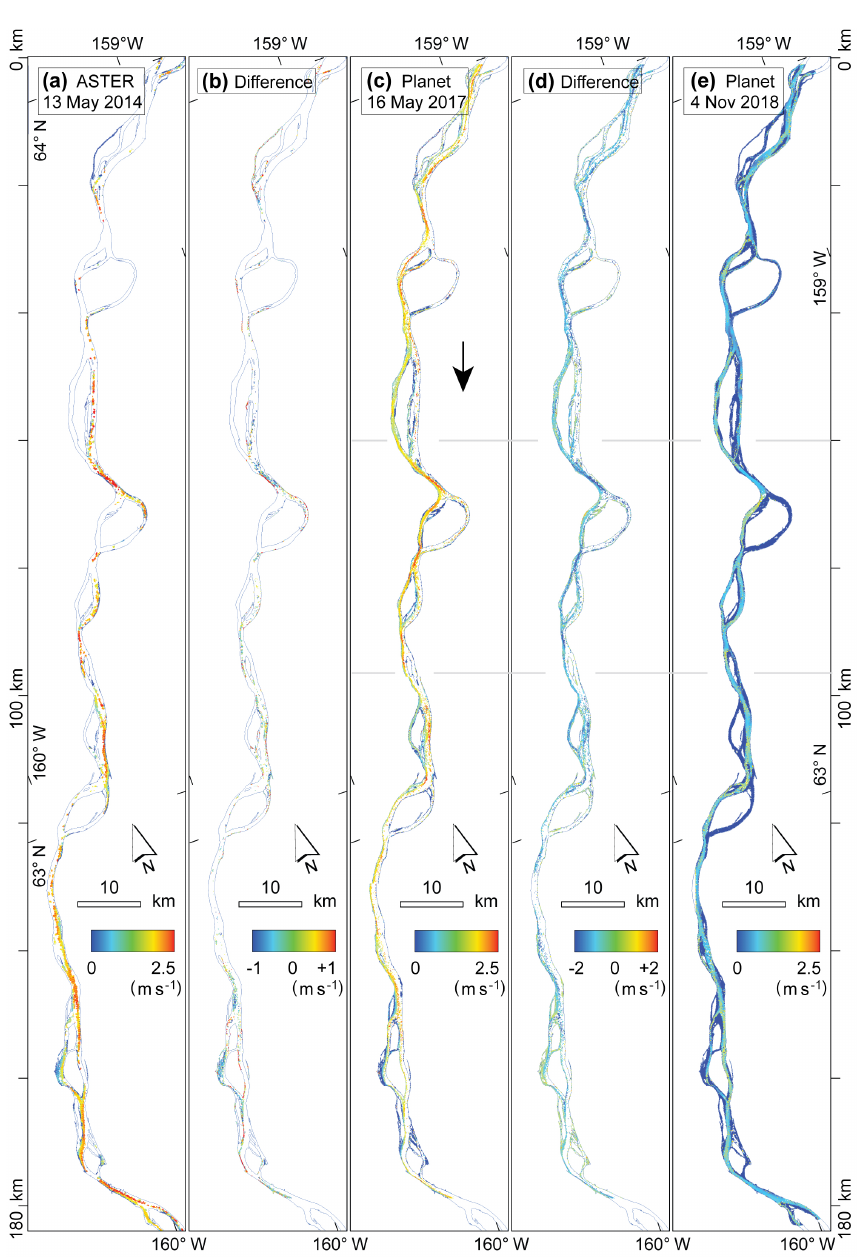
Figure 8. Surface velocities on the Yukon River, Alaska, from near-simultaneous satellite images. The flow direction is roughly from north to south (top to bottom of the figure). Velocities from (a) an ASTER stereo pair from 13 May 2014 (55s time lag), (c) two Planet cubesat image strips from 16 May 2017 (15s), and (e) two Planet cubesat image strips from 4 November 2018 (171s). Panels (b) and (d) show the differences between (c) and (a) and the differences between (e) and (c) respectively. The horizontal grey lines in (c–e) indicate the detail shown in Fig.